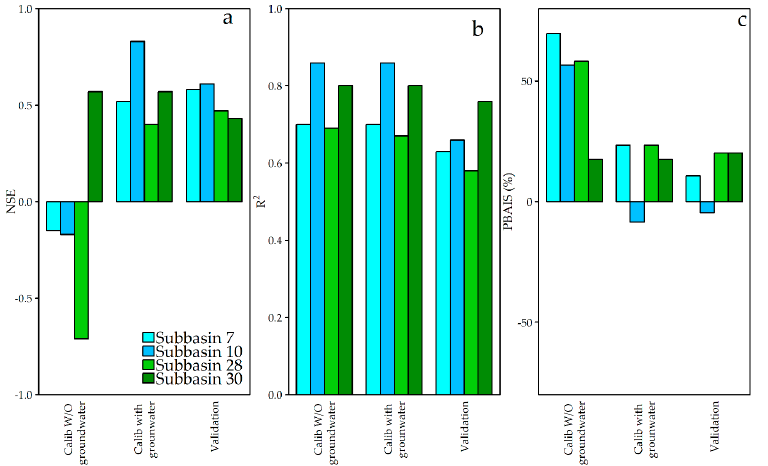
Figure 9. Summary of statistical analysis of the observed and the simulated monthly discharges at the Rabat-i-Bala (sub- basin 7), Pul-i-Baraq (Subbasin 10), Doshqadam (subbasin 28), and Nazdik-i-Nayak (subbasin 30) stations. ( a ) Nash-Sutcliff efficiency (NSE), ( b ) coefficient of determination (R 2 ), and ( c ) percent bias (PBAIS).